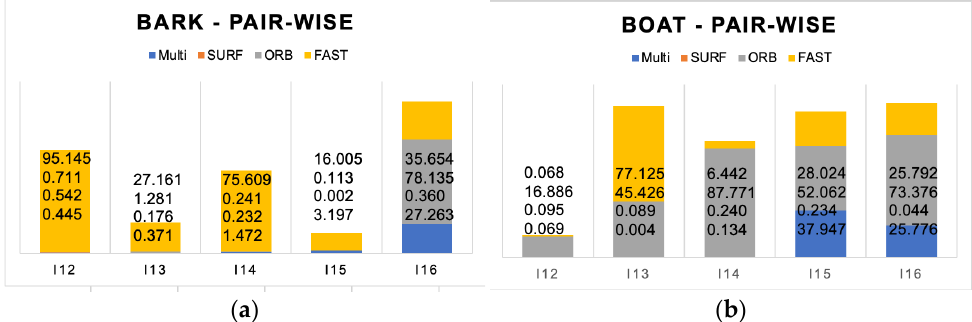
Figure 7. Pairwise RMSE [m] evaluation of H-matrix estimation of bark ( a ) and boat ( b ).